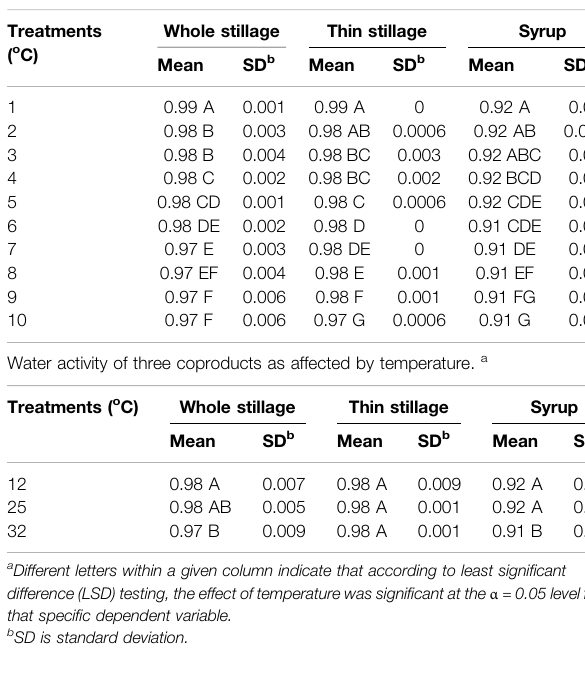
TABLE 4 | Water activity of three coproducts over time. a